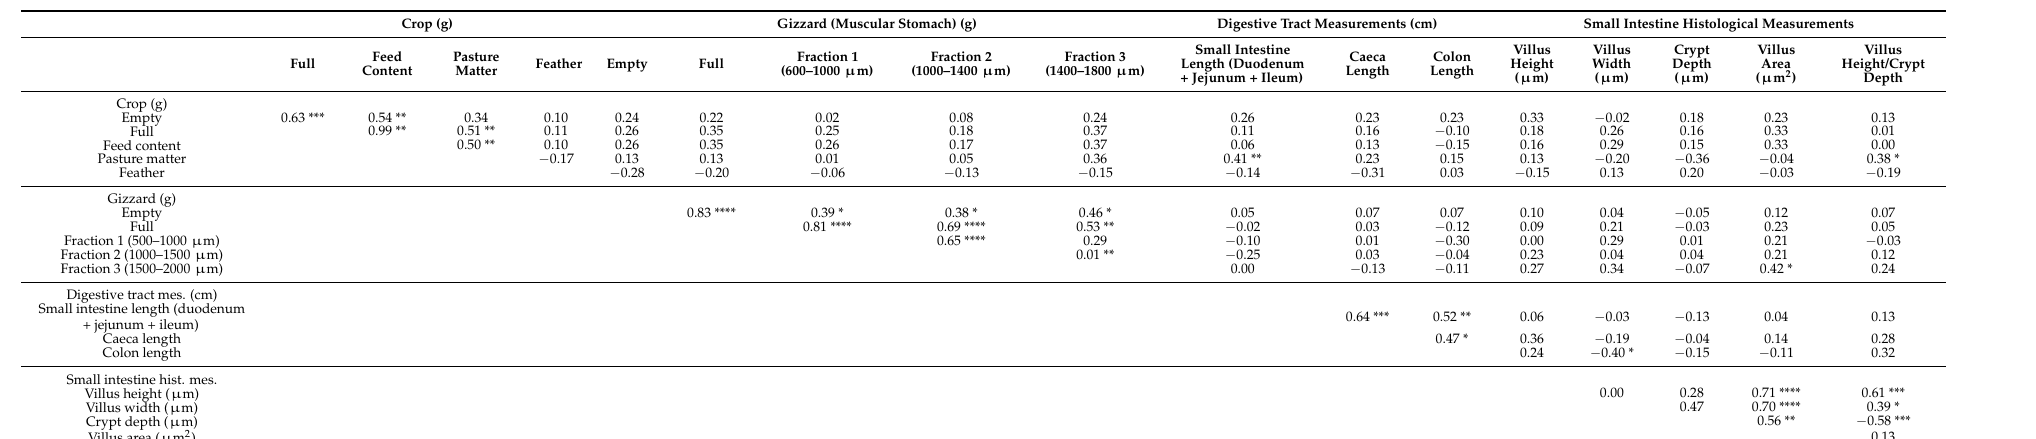
Table 4. Spearman correlations between gastrointestinal tract morphometrics and content of Sasso